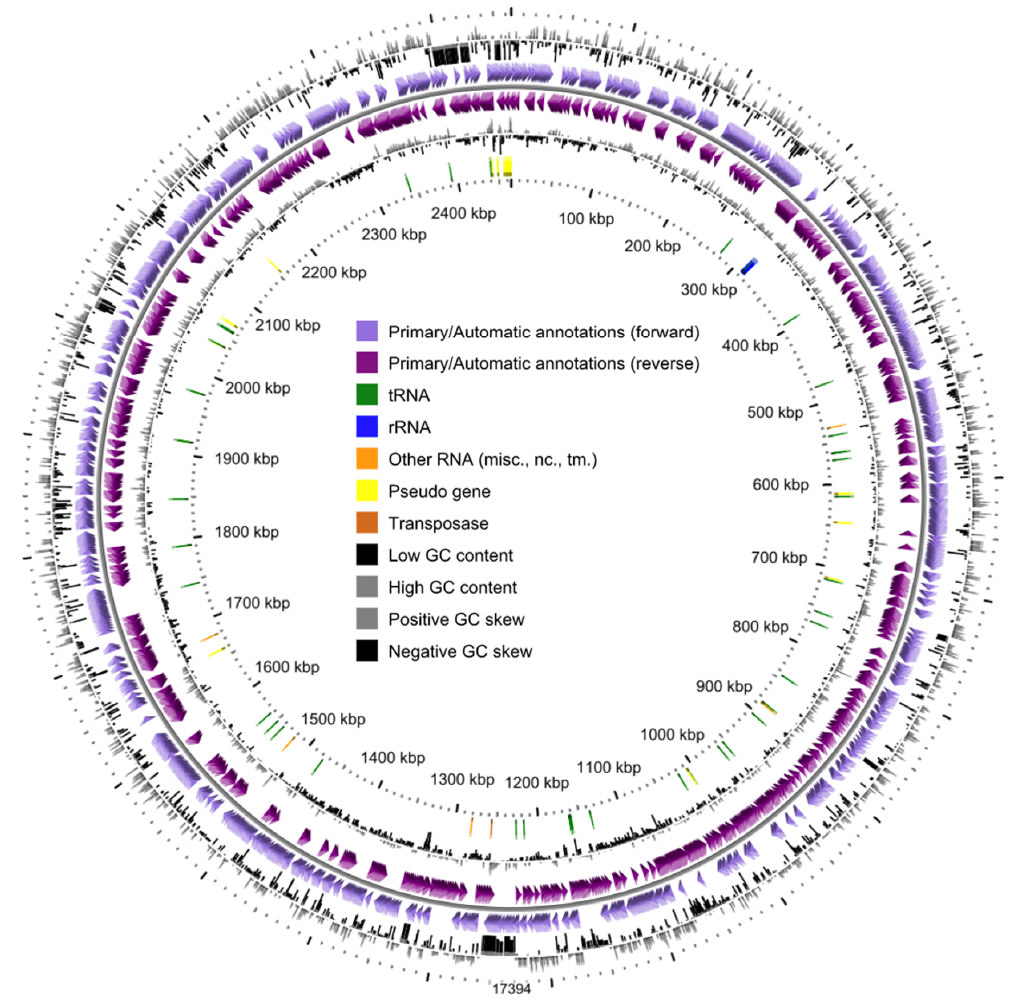
Figure 1. Circular mapping of the genome of Dissulfurirhabdus thermomarina SH388 T from the circular genome viewer of the MaGe platform. GC content: guanine-cytosine content (mol%).